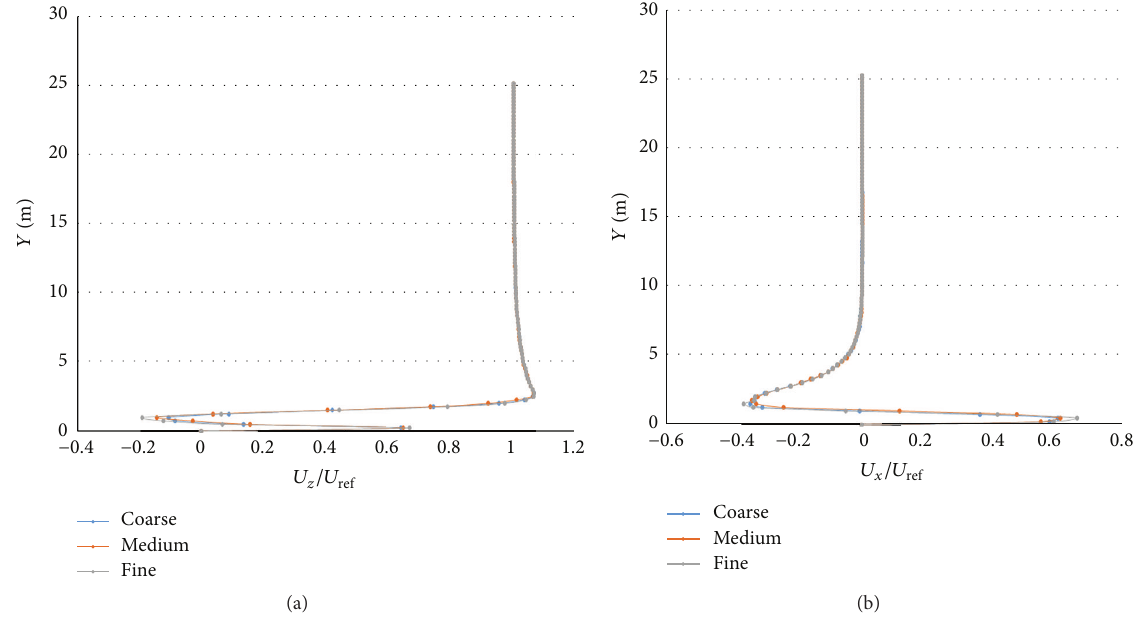
Figure 8: (a) Streamwise and (b) lateral wind velocity (m/s) profiles at location shown in Figure 7 using coarse, medium, and fine meshes.